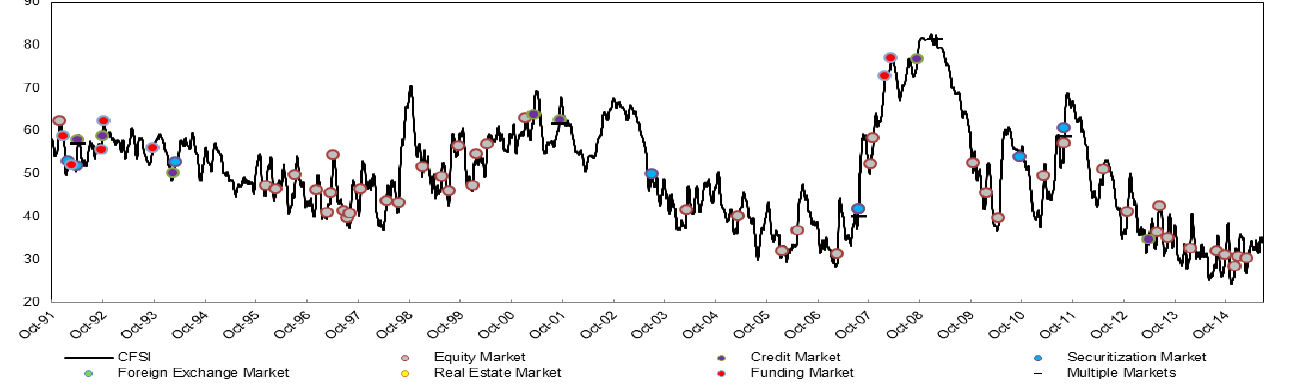
Figure 9. CFSI with alerts by